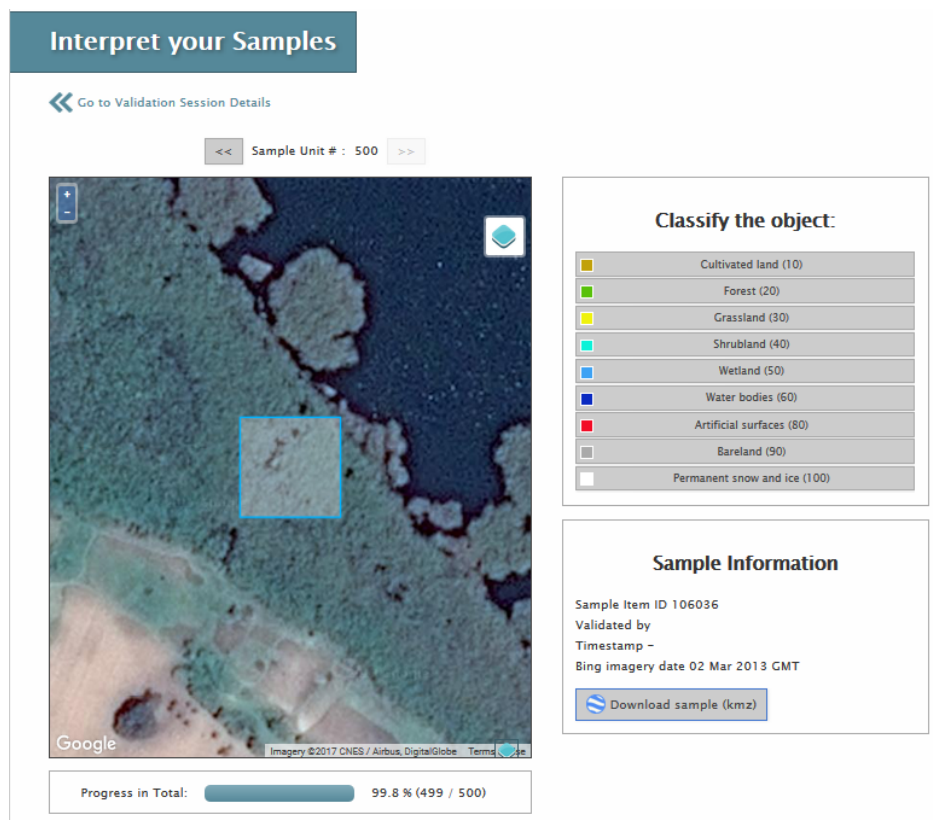
Figure 8. Example of visual interpretation in LACO-Wiki, showing the final pixel in Sample 2 (see Section 3.3). The imagery can be changed to Bing or the pixel can be viewed directly in Google Earth by pressing the “Download sample (kmz)” button.